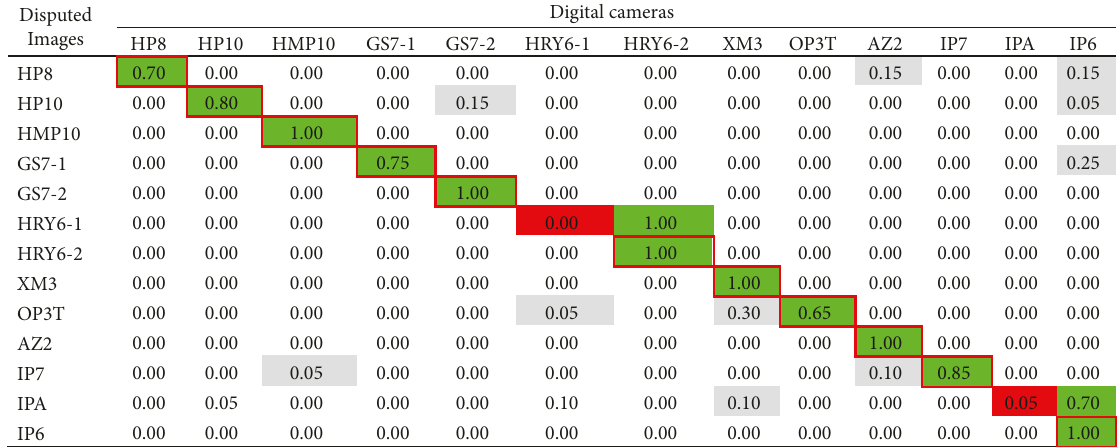
Table 7: Effectiveness of the proposed method when it is applied to the case study that includes natural images as disputed images and the